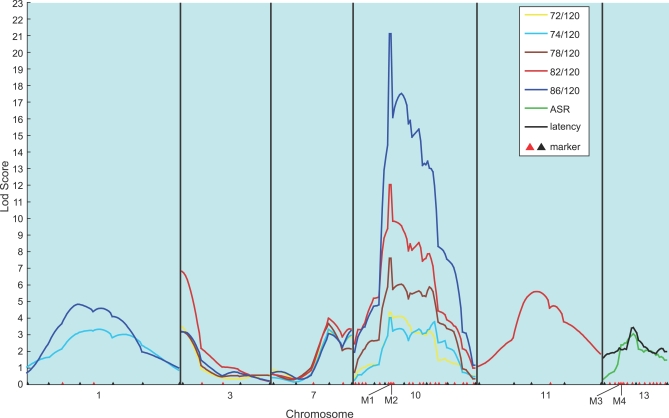
Dense Mapping in Male MiceThe results from the dense mapping of chromosomes in males that harbor significant QTLs detected in the second scan are shown. The chromosomes with lod scores not exceeding the threshold are eliminated. The positions of markers used in the first scan are indicated by black triangles, and those added in the second stage scan (‘dense') by red triangles. Analysis was performed using the MIM method. M1, rs33089794, the nearest verified SNP to Fabp7; M2, Cdh23 SNP; M3, Ofcc1 SNP; M4, Dtnbp1 SNP.